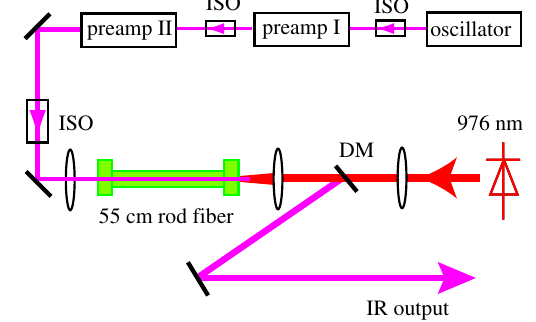
FIG. 6. Schematic of the experimental setup: a fiber oscillator, two preamps, and a main rod amplifier. ISO is optical isolator and DM dichroic mirror.